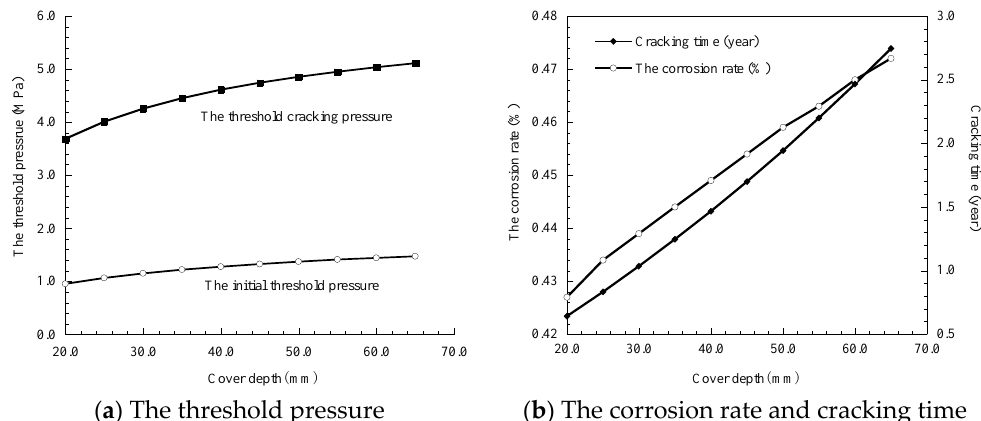
Figure 6. Influence of the cover depth on threshold pressure, corrosion rate and cracking time.